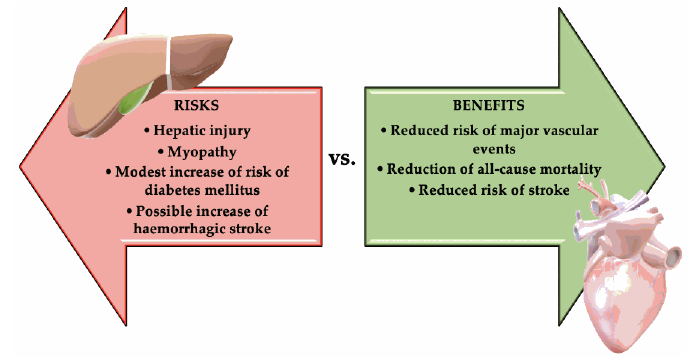
Figure 1. The risks vs. benefits of statins treatment. Table 3. General factors associated with the highest risk of myopathy vs. specific factors for statin-induced myopathy